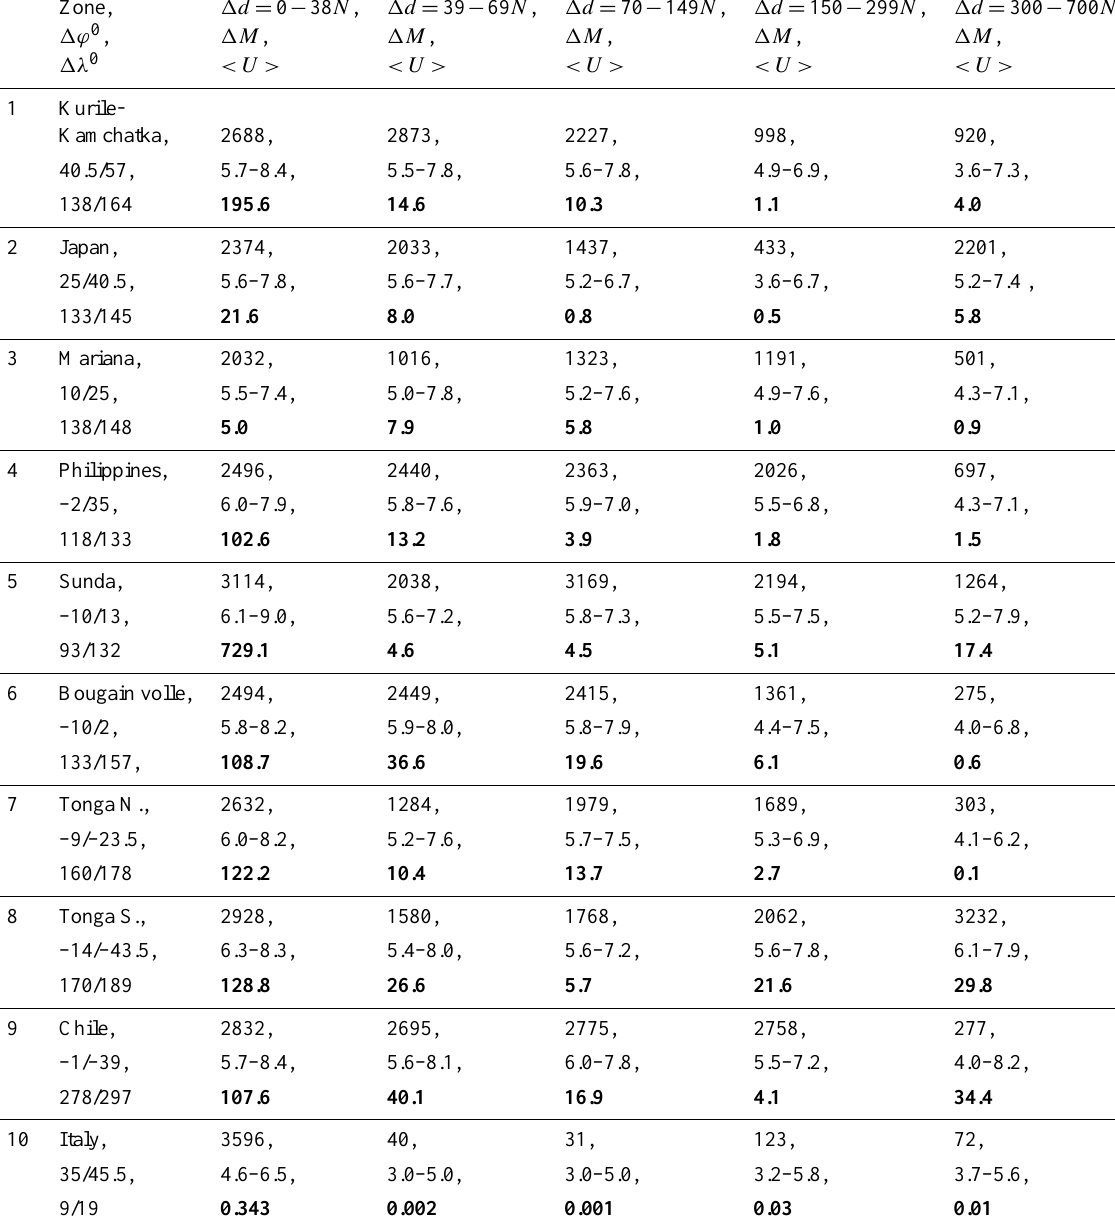
Table 1. Basic information on seismicity in the selected zones. 1ϕ 0 – latitude range of the zone, 1λ 0 – longitude range, 1d – depth range, km, N – total number of EQs used for analysis here for time interval from 1973 to 2008., 1M – range of magnitudes, < U > – average seismic energy release for 6months in 10 14 J. Bold values are important energy zone